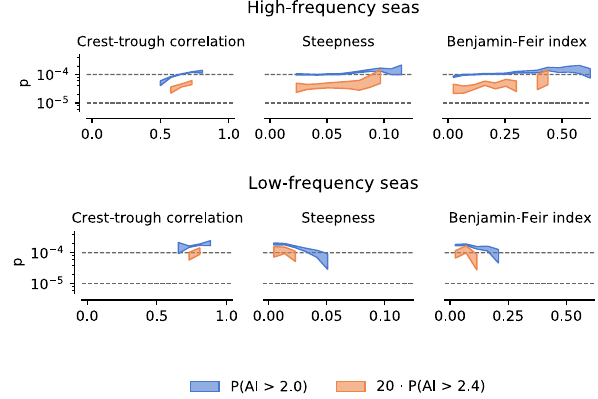
Figure 4. Low-frequency seas have naturally higher rogue wave activity for similar crest-trough correlations, but scale negatively with steepness and BFI. Shown is the scaling of the rogue wave probability p with some sea state parameters. Low-frequency/high-frequency conditions are all seas with relative low-frequency energy in the interval (0.8, 0.85) and (0, 0.1), respectively. Curves for P ( AI > 2.4 ) are scaled by a factor of